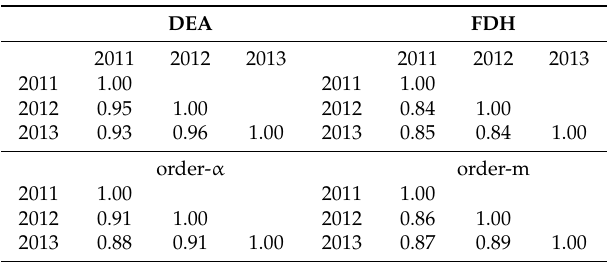
Table 4. Spearman rank correlations for each approach of efficiency analysis across time.